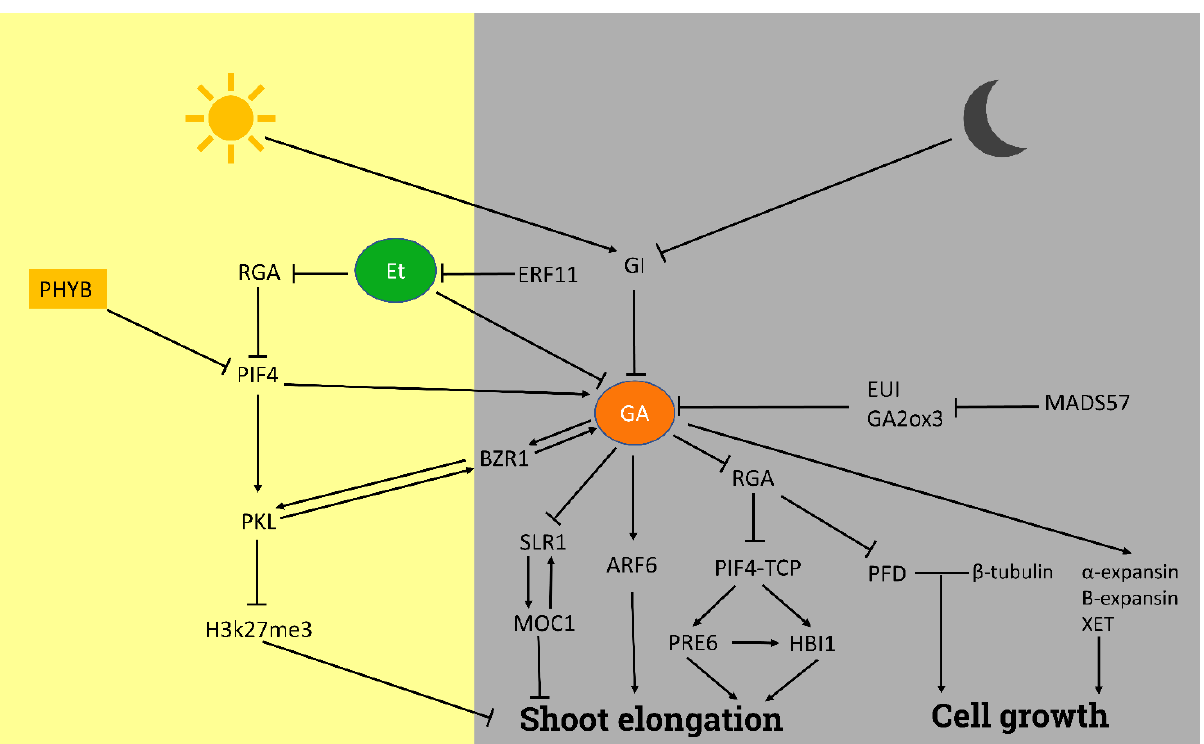
Figure 1. Schematic representation of the GA-related signaling involved in the process of shoot elongation. Yellow and grey background indicate light and dark conditions, respectively. Arrows indicate activation and blunt-end lines indicate repression or inhibition. See text for details